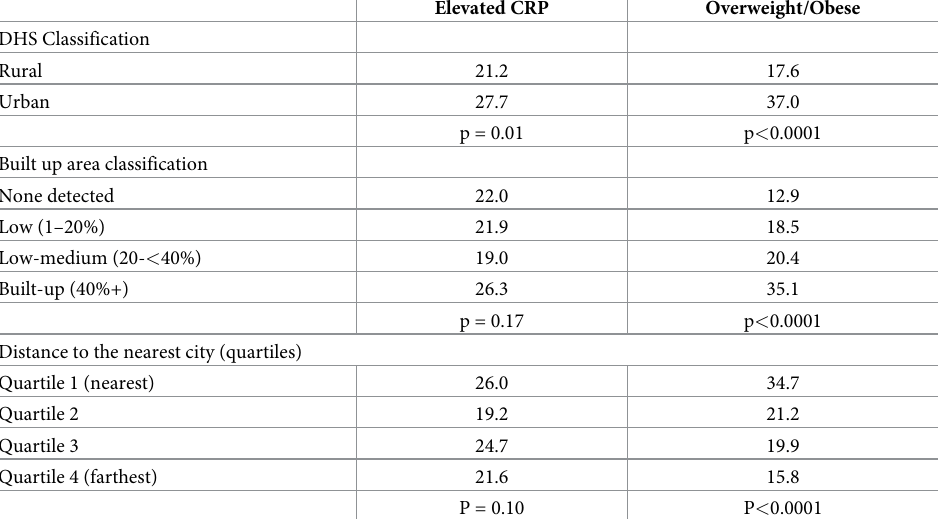
Table 2 tabulates and calculates weighted chi square p-values for comparing elevated to non-elevated CRP, and overweight/obese vs normal weight by three different measures of Table 2. Prevalence of elevated CRP and overweight/obesity by urban vs. rural location and maximum categories of the built environment (and tests of significance,